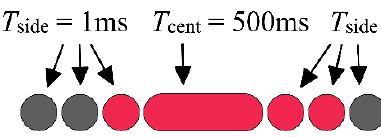
Figure 15. LED array using multiple timers.